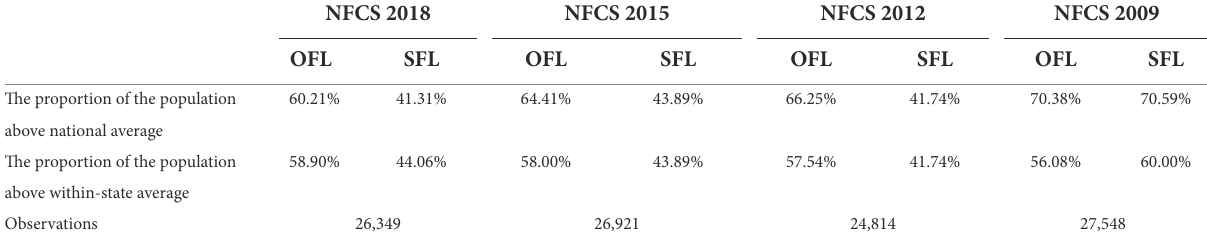
TABLE 6 Population distribution above the state or national average.